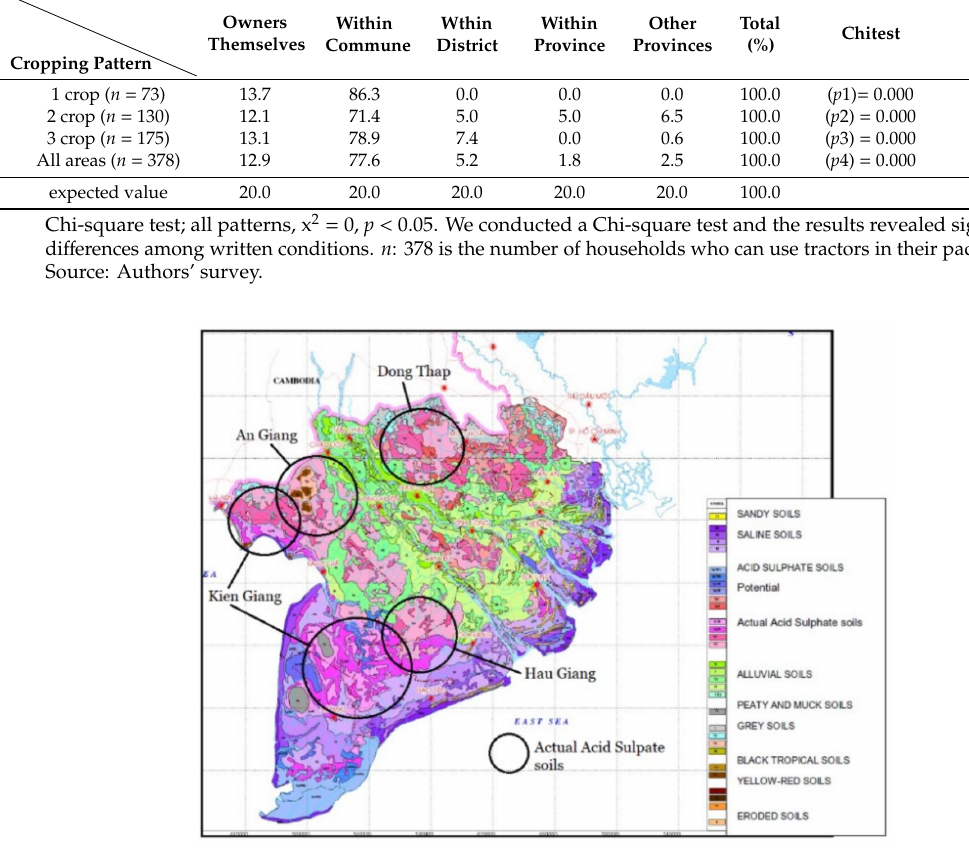
Cropping Pattern